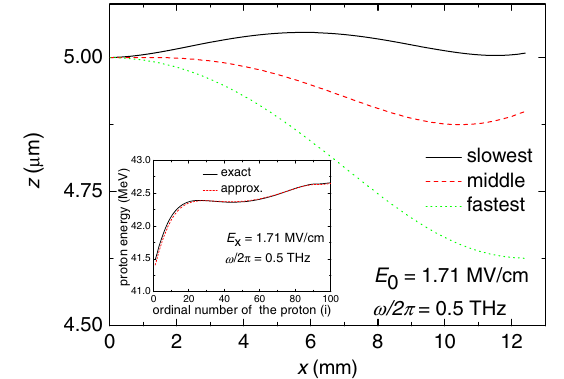
FIG. 7 . Output proton energy distributions for the subsequent stages of a five-stage accelerator sequence in the case of 0.5 THz frequency.